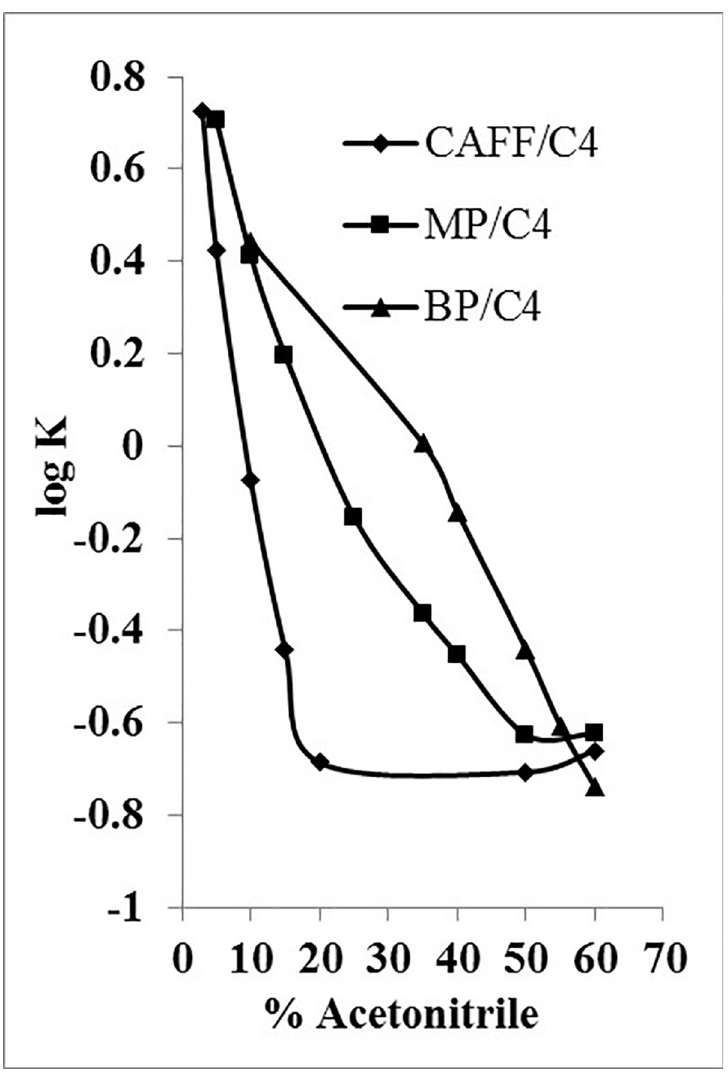
Fig 1. log K of CAFF, MP and BP as a function of acetonitrile concentration using C4